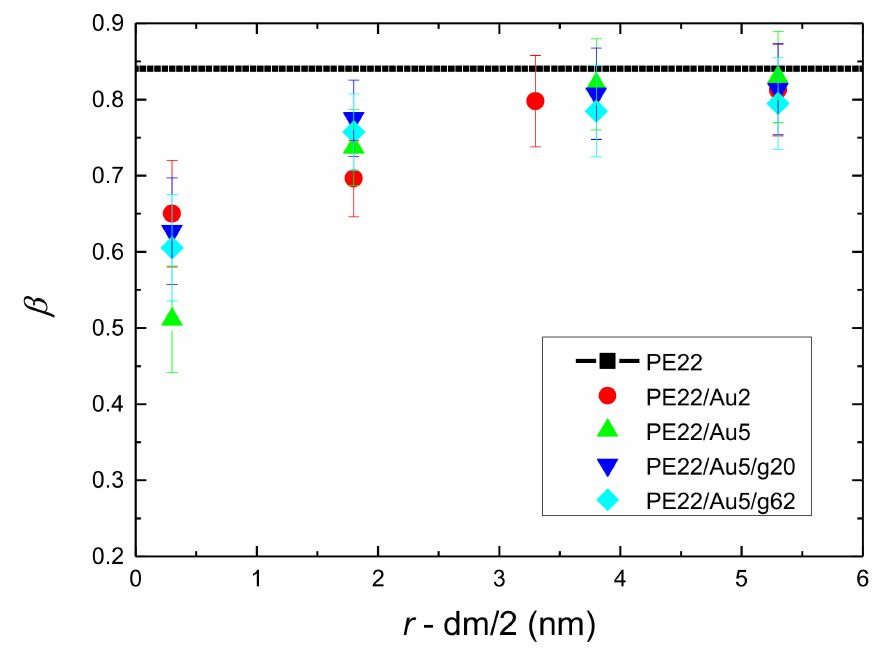
Figure A12. The stretch exponent β , as extracted from the fit with KWW functions, of v end − end characteristic vector based on C end-end ( t ) time autocorrelation as a function of r (distance from the center of the Au NP) minus the half diameter of the NP, for all systems with PE matrices consisting of 22 mers per chain. Black lines represent β values of bulk